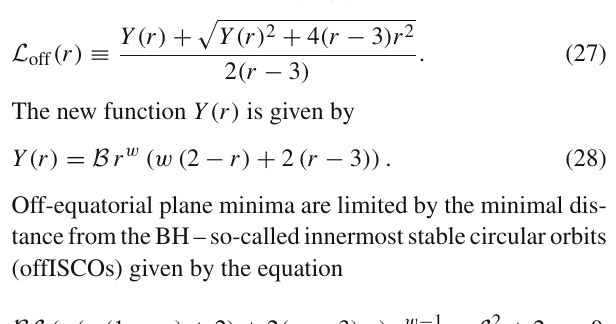
Fig. 2 Effective potential V eff for charged particle dynamics as 2D function of Cartesian x , z coordinates. We can see the effective poten- tial minima at the off-equatorial planes for B < 0 (top left) and the in-equatorial minima for B > 0 (top right). The lower row of figures